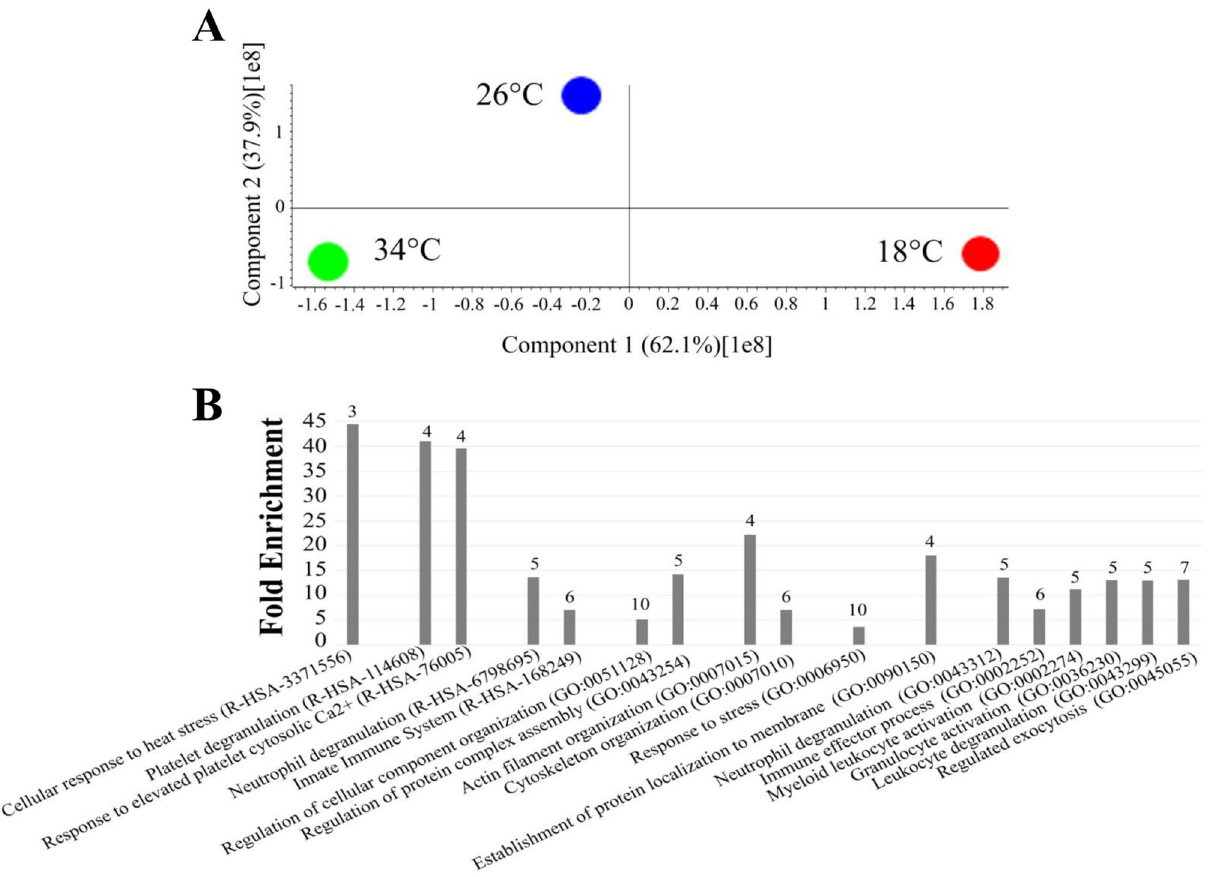
Figure 6. PCA and Panther analysis of the proteome of zebrafish kept at 18 °C, 34 °C and 26 °C. ( A ) PCA analysis of the proteomes of zebrafish kept for 4 days at 18 °C, 26 °C and 34 °C. ( B ) Panther analysis of the proteins differentially expressed among the three data set: 18 °C, 26 °C and 34 °C. The numbers on top of each column indicates the number of genes present in each category. Functional grouping was based on P ≤ 0.05 and at least three